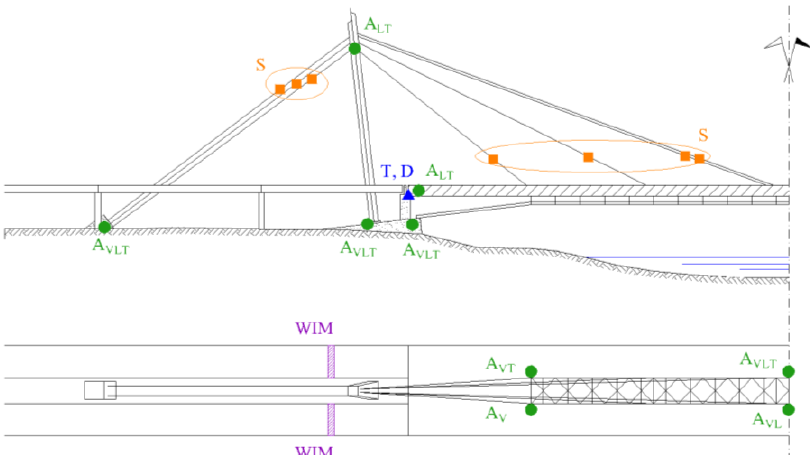
Figure 3. Proposed monitoring system, where: A (green circle) stands for accelerometers and the subscripts V, L and T represent the vertical, longitudinal and transversal direction of the sensor, respectively; S (orange square) represents the accelerometers and the strain gauges placed on the cables; T and D (blue triangle) stand, respectively for tiltmeter and relative displacement sensors on the deck; WIM (purple) stands for weight-in-motion